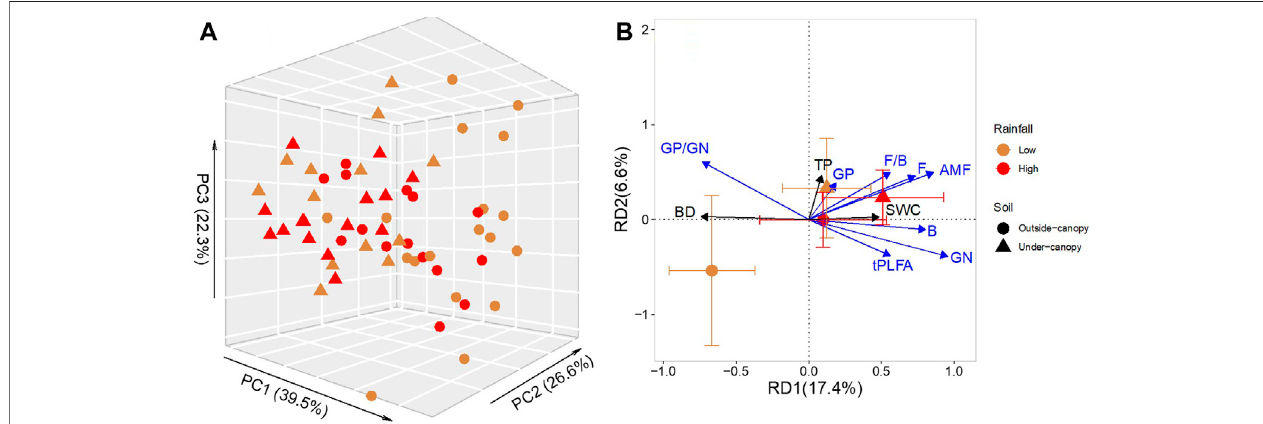
FIGURE 3 | (A) 3-dimensional scatterplots for the principal component analysis (PCA) of microbial community composition and (B) biplot for the redundancy analysis (RDA) of relationships between the microbial community and physicochemical properties in soil under (Under-canopy, fi lled triangle) and outside the canopy (Outside-canopy, fi lled circle) of shrub species Artemisia gmelinii from sites oflow (brown) and high rainfall (red). Percentage ofdata variation explained by each principal component is shown in its respective parentheses.